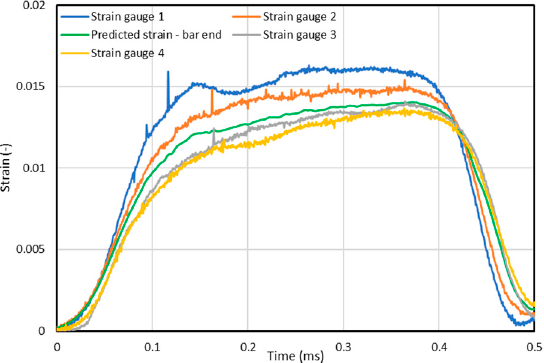
Figure 5. Comparison of signals recorded 900 mm (Strain gauge 1) and 450 mm (Strain gauge 2) from incident bar forehead; signals recorded 150 mm (Strain gauge 3) and 300 mm (Strain gauge 4) from transmission bar forehead and forecast.